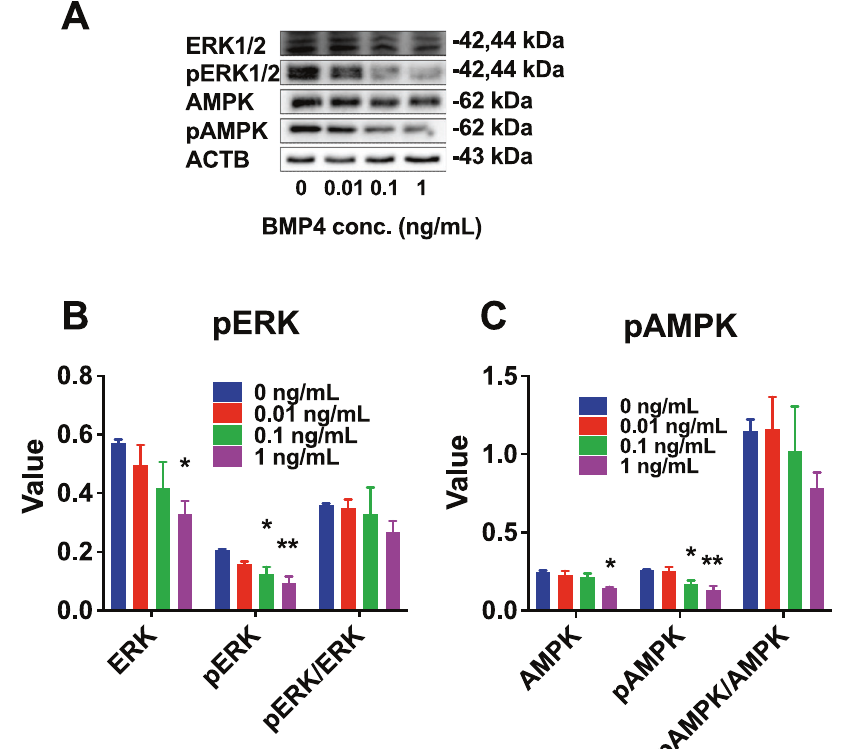
Fig. 6 Kinase and phosphorylated kinase protein levels after 3-week BMP4 treatment to seminiferous tubules (STs) in vitro. A Western blot; B , C Quantitative data of pERK1/2, ERK1/2, pAMPK, AMPK, and their ratio. Mean ± SEM, n = 3. * P < 0.05 and ** P < 0.01 indicate signi fi cant differences compared to control (0 ng/mL